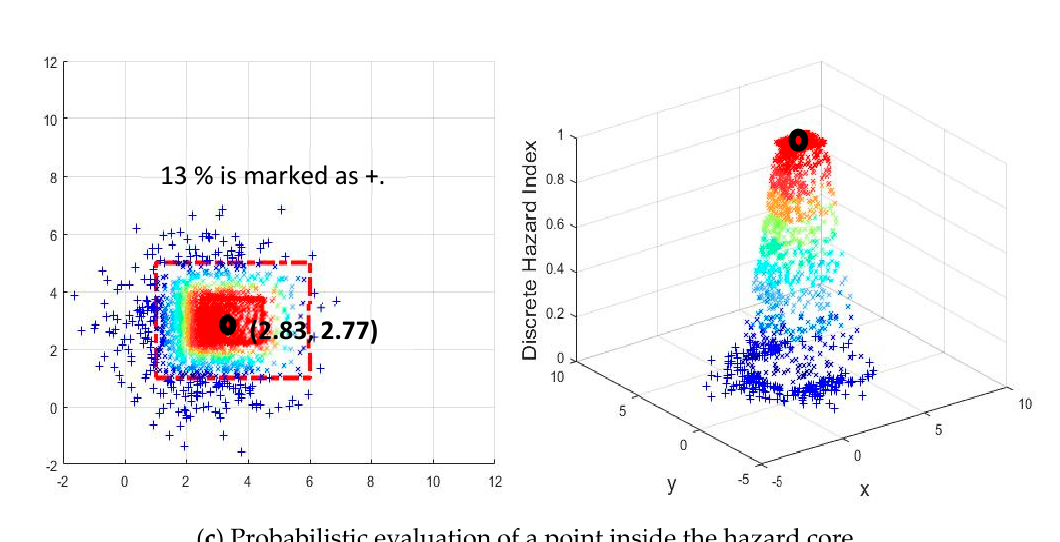
Figure 8. Evaluation of sample points from Scenario 2 of Testbed 2.